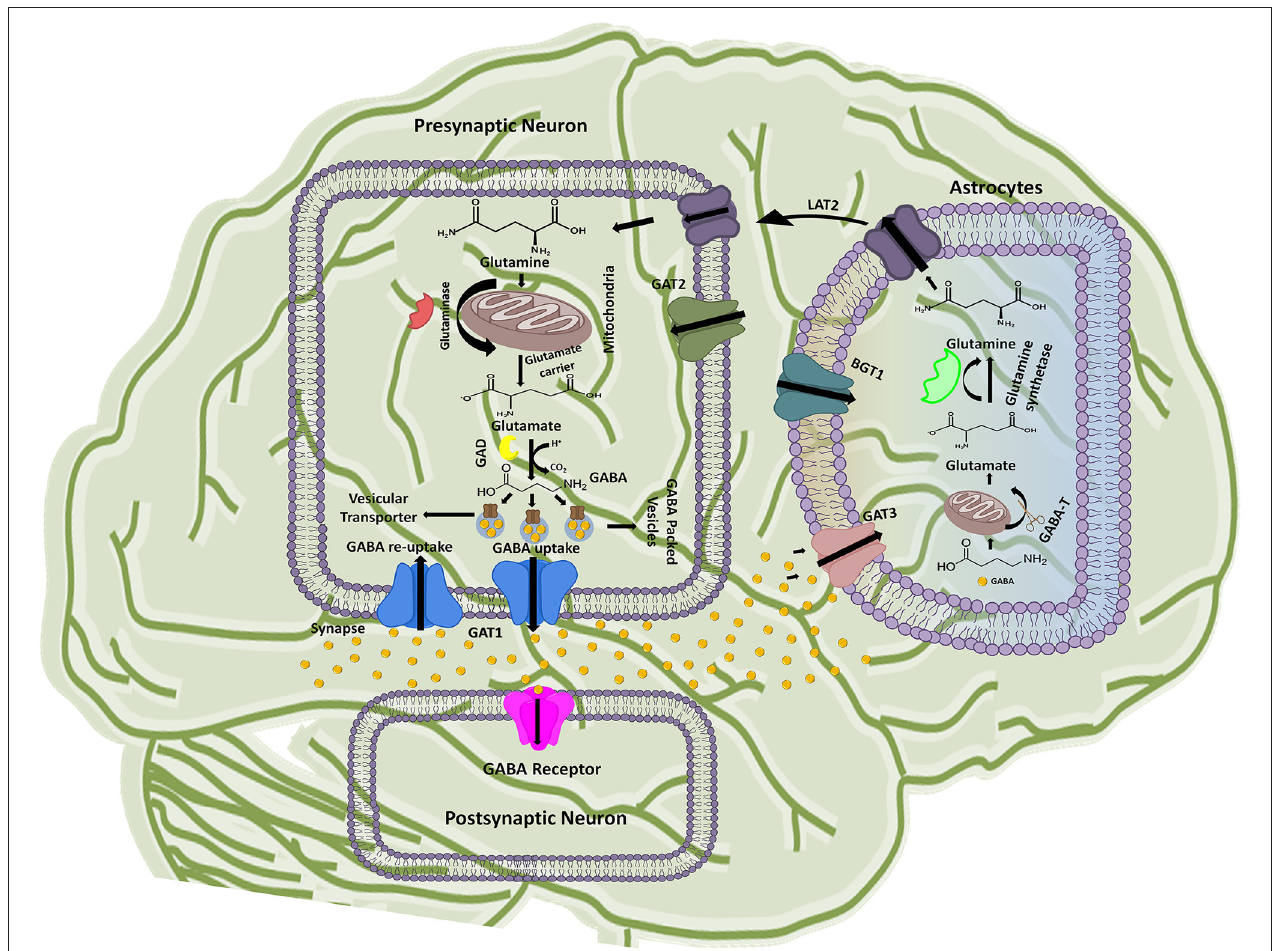
FIGURE 1 | Schematic illustration of GABA synthesis, release, uptake, re-uptake, and metabolism in the CNS. In the presynaptic neuron, conversion of glutamine to glutamate followed by the GABA synthesis is represented along with the respective catalytic enzymes and transporters. GABA receptor present on the post-synaptic neuron receives the signals from the presynaptic neuron while astrocytes functions to metabolize the extra amount of GABA in the synaptic cleft and process it to glutamine. The processed glutamine is transported to the presynaptic neuron with the help of Linker for activation of T-cells family member 2 (LAT2) transporter. Thus, synthesis of GABA in presynaptic neuron is started again on the arrival of new